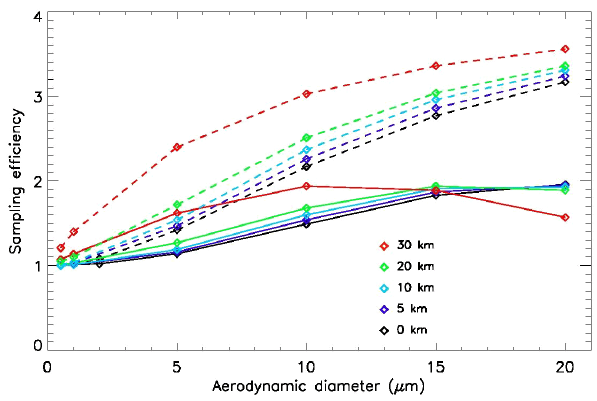
Figure 8. Efficiency of the sampling line at different altitudes from the surface up to 30km; dashed lines: isoaxial conditions; full lines: 30 ◦ deviation from isoaxial